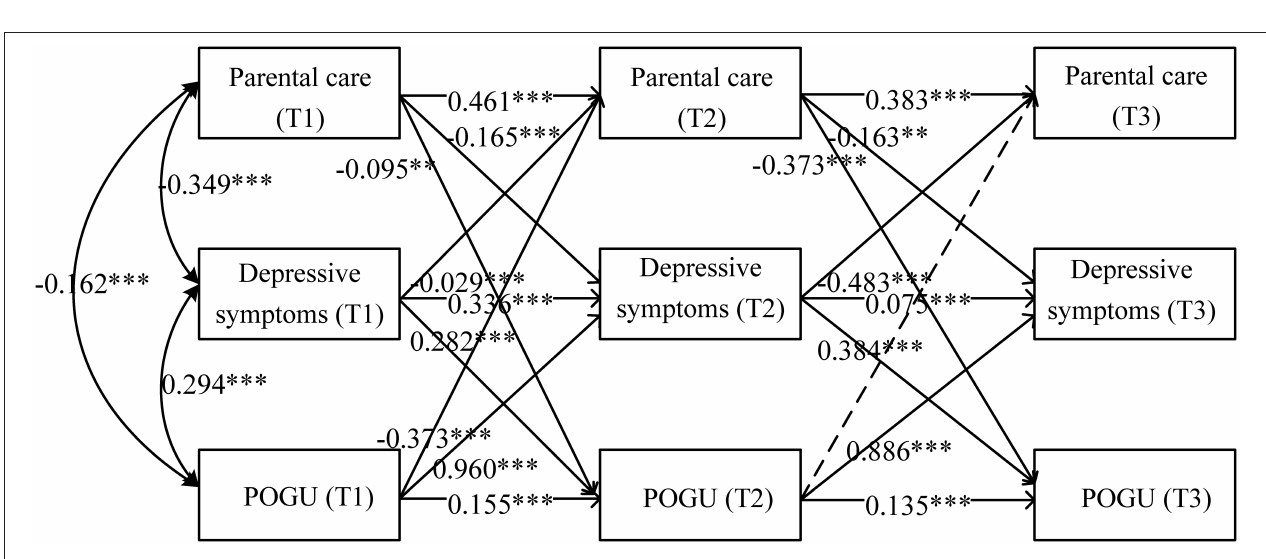
FIGURE 1 | Developmental cascades model of parental care, depressive symptoms, and POGU at T1, T2, and T3. POGU, problematic online game use. Dashed lines represent non-significant paths. The path coefficients are standardized coefficients. ** p < 0.01, *** p < 0.001.